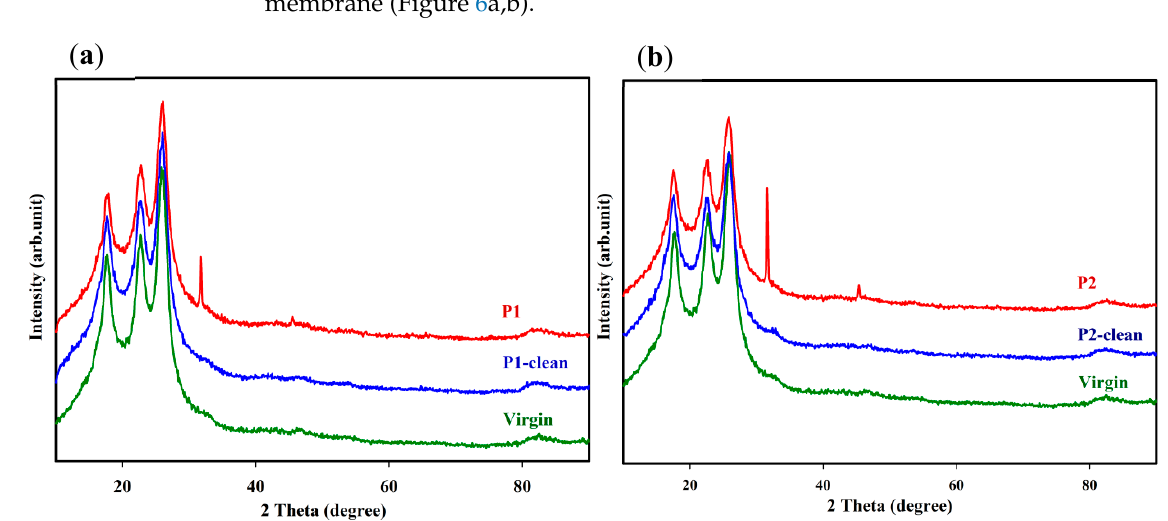
Figure 6. XRD diffraction patterns of fouled membranes (P1 and P2) and virgin membranes ( a ) before and ( b ) after cleaning with acid and base media.